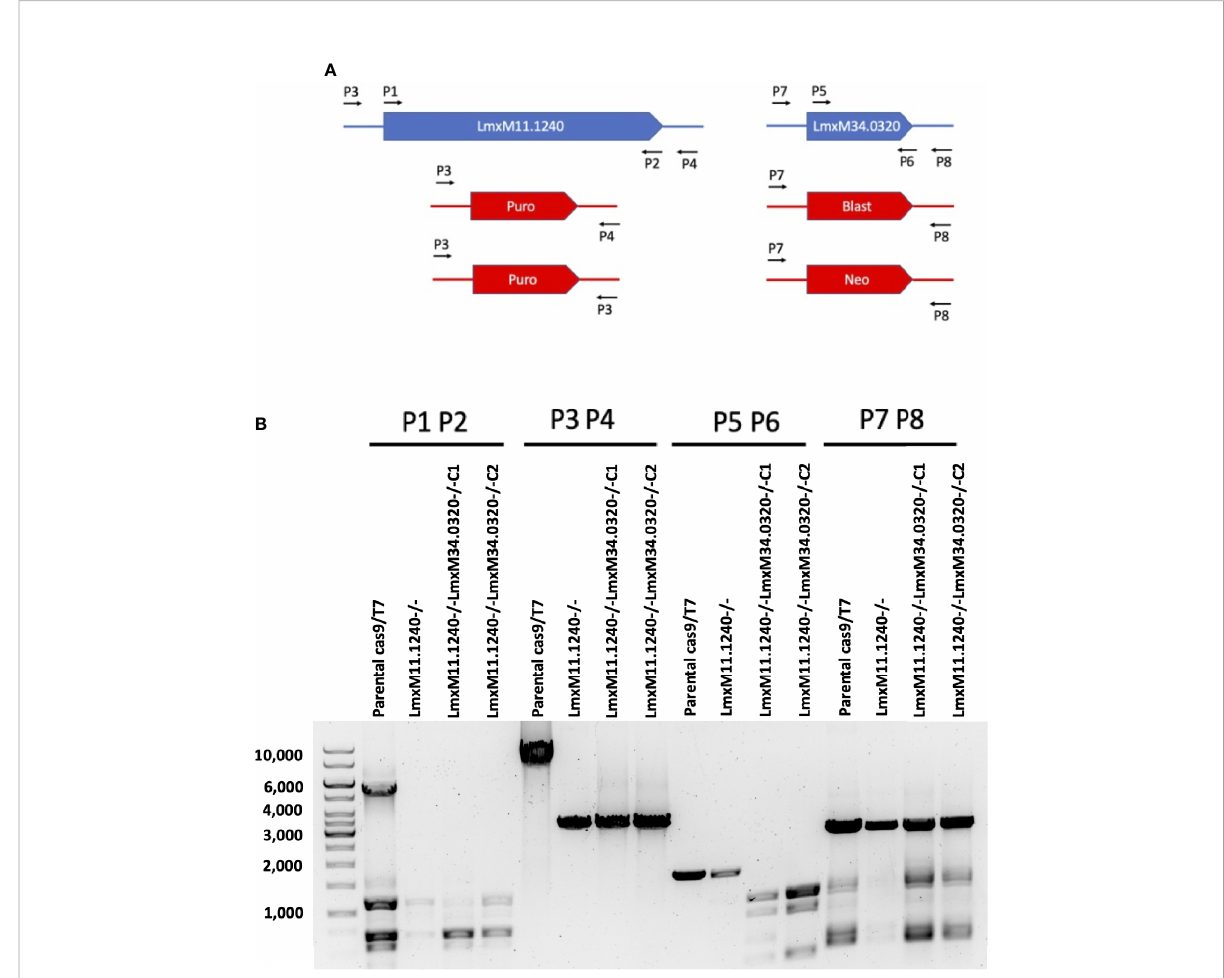
FIGURE 4 CRISPR Cas9 mediated knockout of LmxM.11.1240 and LmxM.34.0320. (A) Illustrates a schematic of the approach taken and the primers P1 to P8 (see section 2.3 for a detailed list) employed for analyses. (B) Shows the diagnostic PCR results from the knockouts of LmxM.11.1240 (LmxM.11.1240-/-) and LmxM.11.1240/LmxM.34.0320 (LmxM.11.1240-/-LmxM.34.0320-/-) following selection in Blasticidin/G418 and/or Puromycin and single cell cloning. Puro is the puromycin resistance cassette (1.8bk), Blast the Blasticidin (1.7kb) and Neo the G418 (1.75kb).